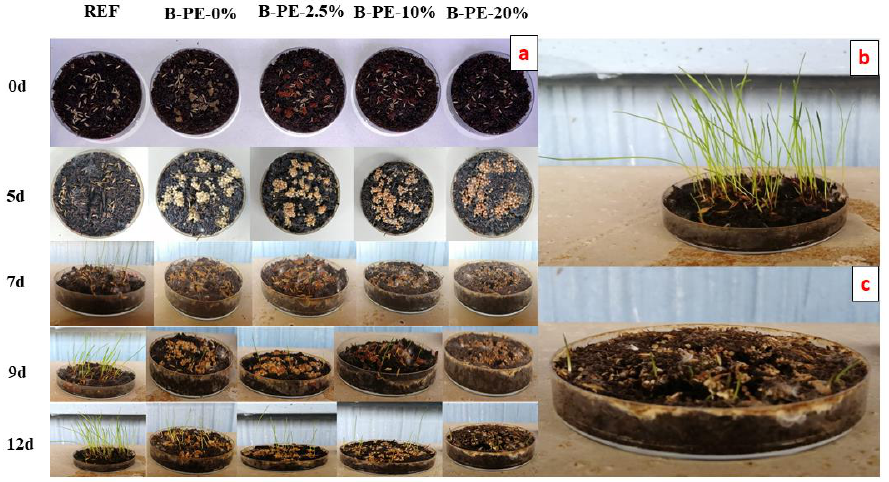
Figure 10. ( a ) Weeds growth over time; ( b ) effect of B-PE-0%; and ( c ) B-PE-20% on weeds growth after 12 days.